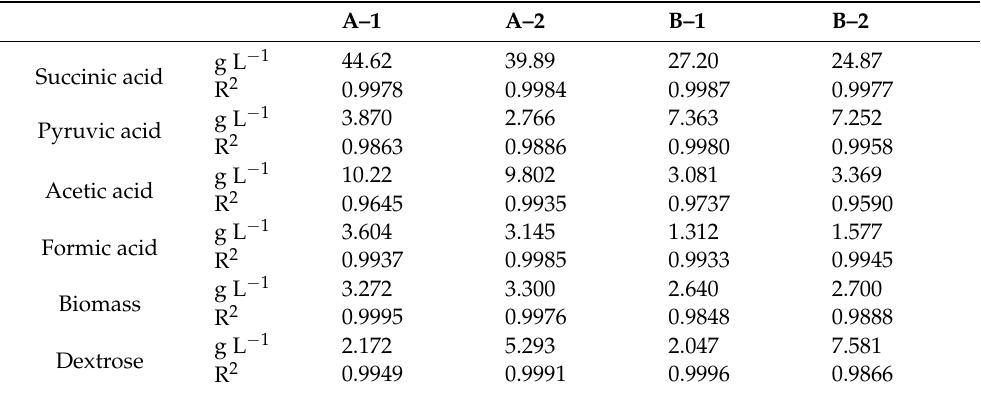
Table 1. The final titres (g L − 1 ) and goodness of fit (R 2 ) of each respective fitted curve at fermentation